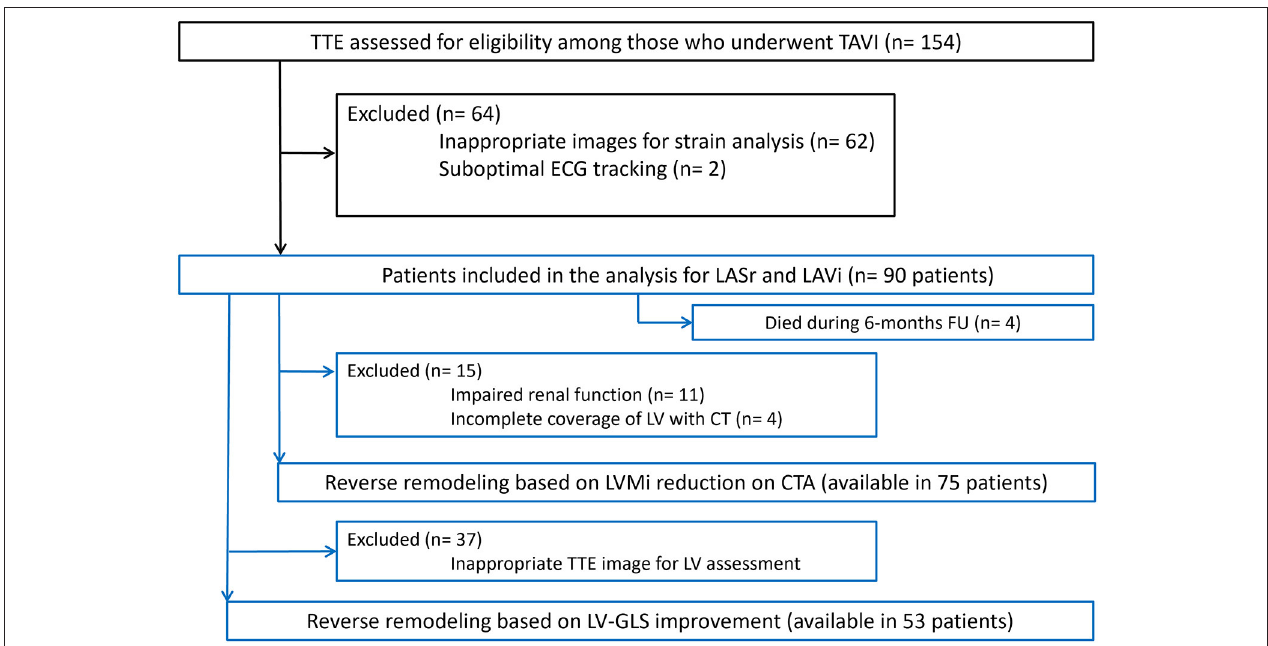
FIGURE 1 | Flowchart of patients through the study. CTA, CT angiography; ECG, Electrocardiography; LA, Left atrium; LASr, Left atrial peak reservoir strain; LAVi, Left atrial volume index; LV-GLS, Left ventricular global longitudinal strain; LVMi, Left ventricular mass index; TAVI, Transcatheter aortic valve implantation; TTE, Transthoracic